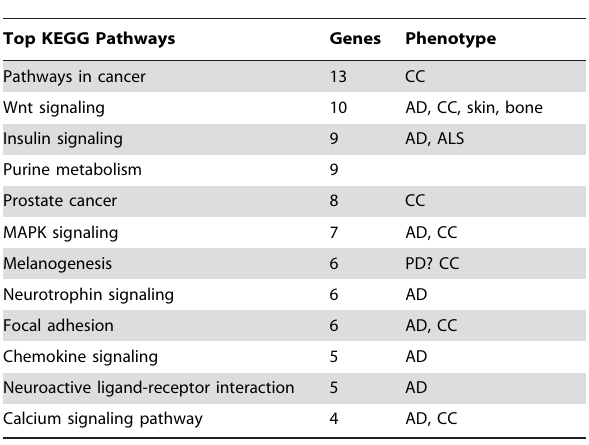
Top brain KEGG pathways (derived from 443 MAM-modulated genes, see Table 3) and the number of MAM-modulated genes and human diseases associated with each pathway. Note the prominent involvement of the Wnt, insulin and MAPK signaling pathways, in addition to the presence of pathways involved in inflammatory and other responses. AD: Alzheimer disease. ALS: Amyotrophic lateral sclerosis. CC: Colon cancer. PD: Idiopathic Parkinson’s disease.